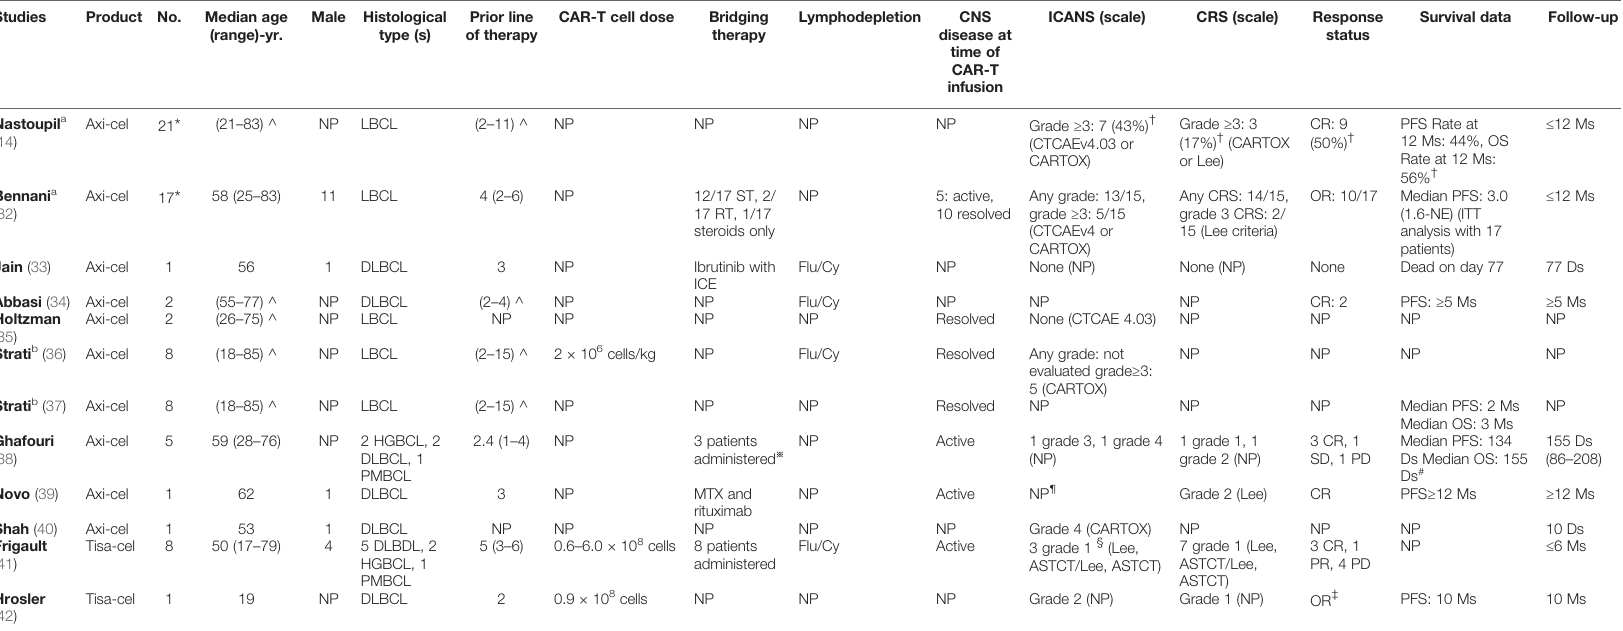
TABLE 2 | The baseline characteristics of included studies. Studies Product No. Median age (range)-yr.